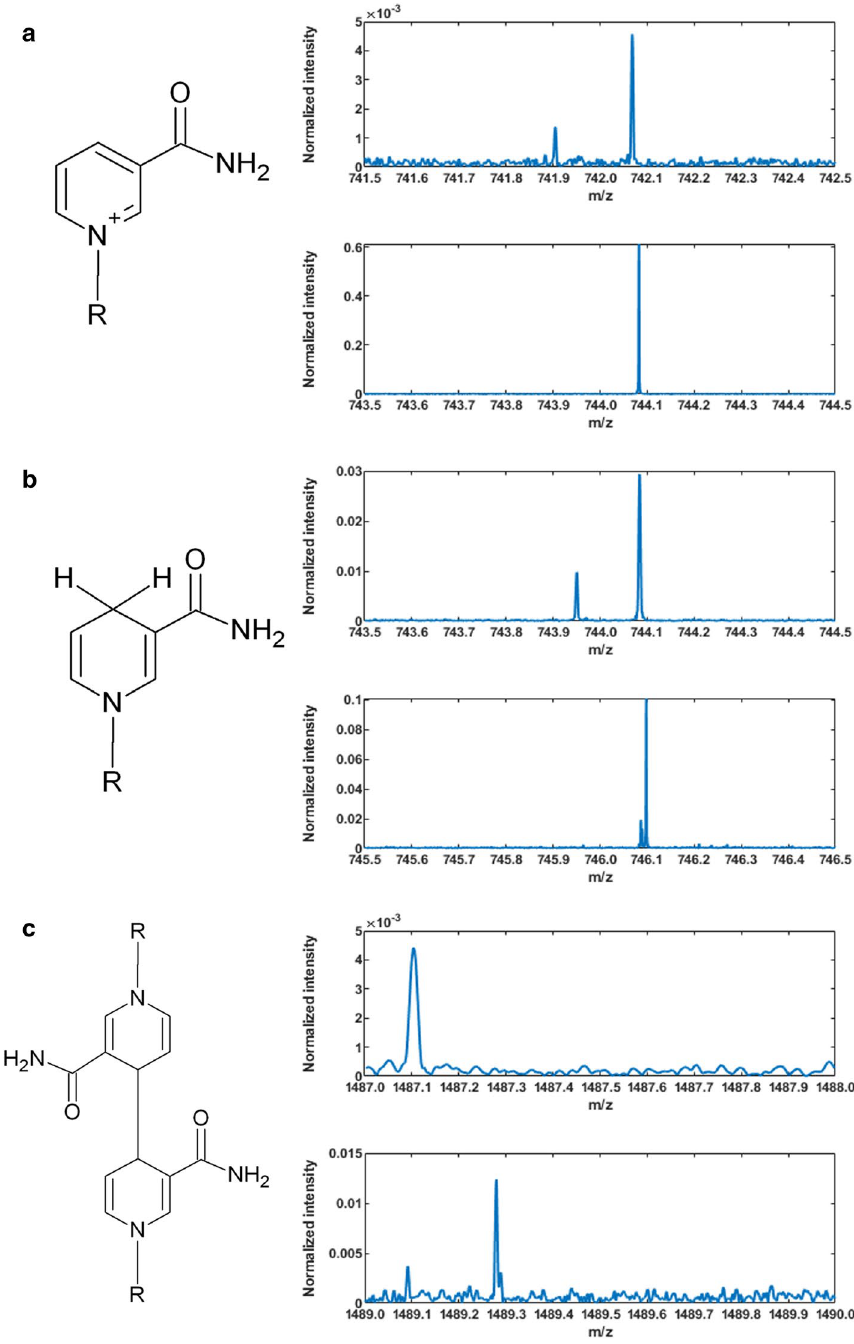
Figure 7. High-resolution FT-ICR MALDI spectra of products of NADPH electrochemically regenerated with photoelectrochemically surface modified Ni–Cu 2 O–Cu cathode. Mass-to-charge (m/z) ratios corresponding to NADP + (a) , NADPH (b) , and (NADP) 2 dimer (c) in the product. For each molecule, the top plot represents spectra obtained in negative-ion mode and the bottom plot represents spectra obtained in positive-ion mode. Presence of singly ionized NADP + and NADPH is indicated in both positive- and negative-ion modes. No strong peaks were observed for singly ionized dimer in either positive- or negative-ion